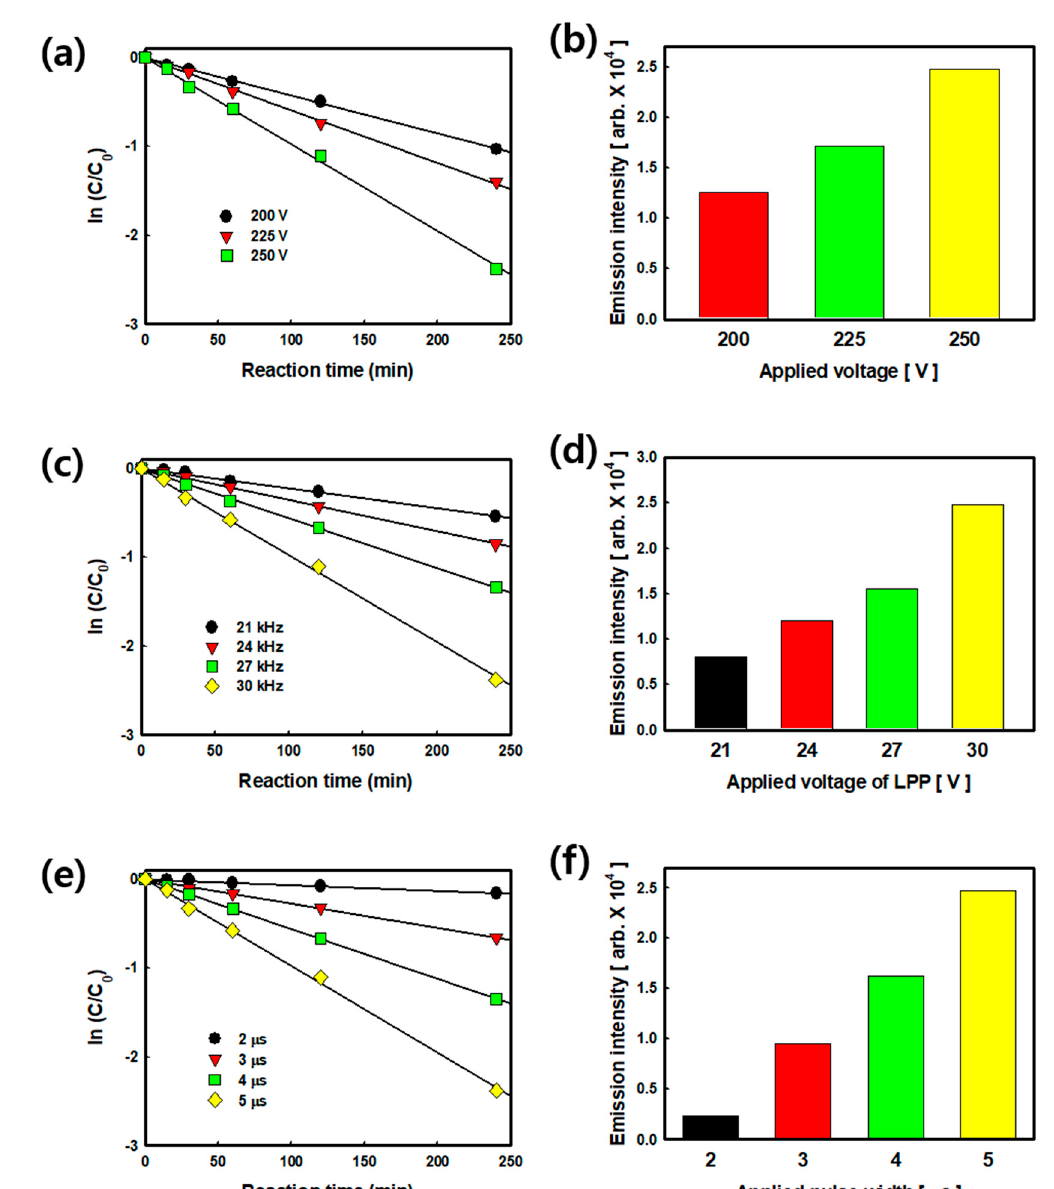
Figure 1. Degradation rate of ASA ( a , c , and e ) and the emission intensity of hydroxyl radicals ( b , d , and f ) according to the electrical power condition of the PiLP: variation of applied voltage ( a and b ); variation of frequency ( c and d ); variation of pulse width ( e and f ).